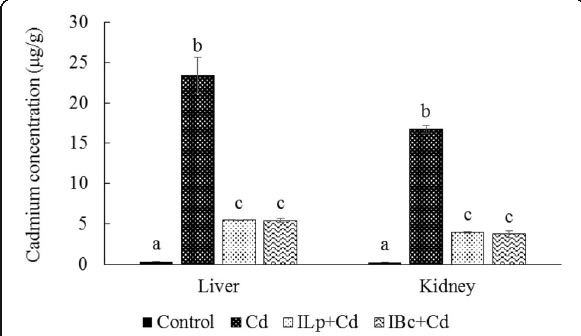
Fig. 3 Effect of synbiotic diet on the accumulation of cadmium in liver and kidney of rats at day 42 of treatments. Cd: cadmium; ILp + Cd: inulin, Lactobacillus plantarum and cadmium; IBc + Cd: inulin, Bacillus coagulans and cadmium. All results are expressed as mean and standard deviation. The different letters indicate statistically significant differences ( P <